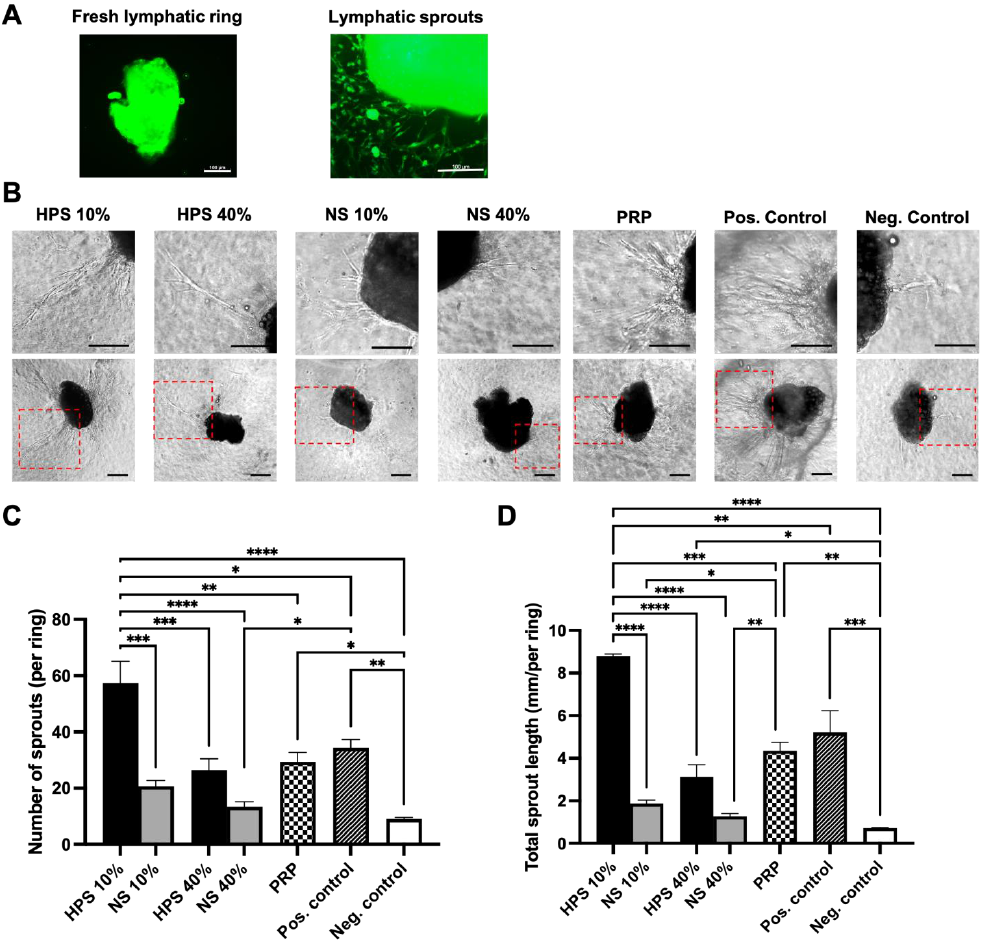
Figure 4. The effect of HPS, NS, and PRP on ex vivo lymphatic ring sprouting. ( A ) Validation of the lymphatic ring assay: Representative image of immunohistochemical staining of a thoracic duct ring with Anti-LYVE-1 (green fluorescence) before culture (left) and validation of lymphatic origin of the sprouts after 11 days with HPS-10%-stimulation (right). Scale bars = 100 µm. ( B ) Panel showing representative images of lymphatic ring cultures (11 days culture), stimulated by HPS/NS-10%, - 40%, and PRP compared to positive/negative control (second row). The first row demonstrates en- larged images of sprouts from the dotted red boxes of the second-row panel. Scale bars = 100 µm. ( C , D ) Image analysis of the digital photographs depicted in ( B ): ( C ) Plot showing the number of sprouts and ( D ) total sprout length of thoracic ducts. The length was measured in mm of the digi- tally captured microscopic photographs. One-way repeated- measures ANOVA with Tukey’s mul- tiple comparison test. Data points are means ± SEM, thoracic duct donors: n = 3. * p < 0.05, ** p < 0.01, *** p < 0.001, **** p < 0.0001.